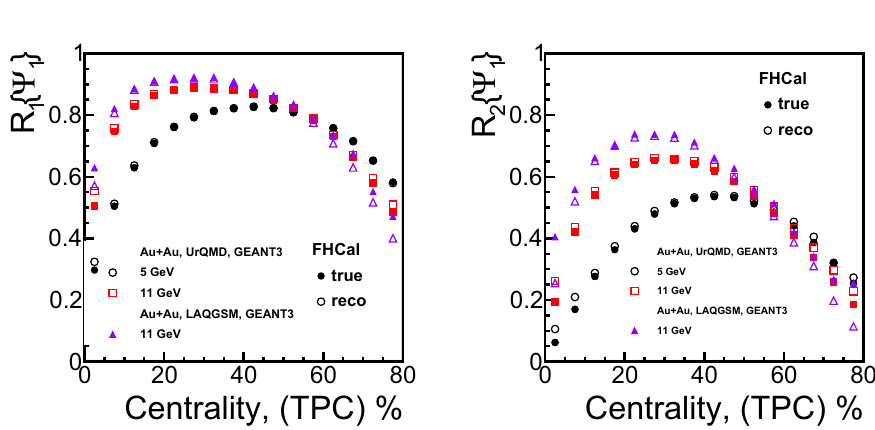
Figure 1. Resolution correction factor as a function of centrality for v 1 (left) and v 2 (right) for the UrQMD and LAQGSM event generators. The results from the GEANT3 simulation marked as true and one from the reconstruction procedure are marked as reco